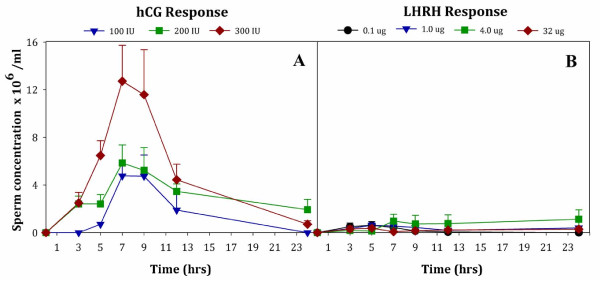
Sperm concentration (x 106/ml) produced by male Anaxyrus americanus over 24 hrs after hormone administration with either hCG (Panel A) or LHRH (Panel B). Male toads were treated with 3 different concentrations of hCG at 100 IU (triangles); 200 IU (squares) or 300 IU (diamonds). Alternatively, males were treated with 4 different concentrations of LHRH at 0.1 μg (circles); 1.0 μg (triangles); 4 μg (squares) or 32 μg (diamonds). Only one male administered 50 IU hCG produced sperm and was not included in Panel A. Data are expressed as Mean ± SEM; lower SEM bars not shown. For number of animals comprising each treatment Mean see Figure 1.